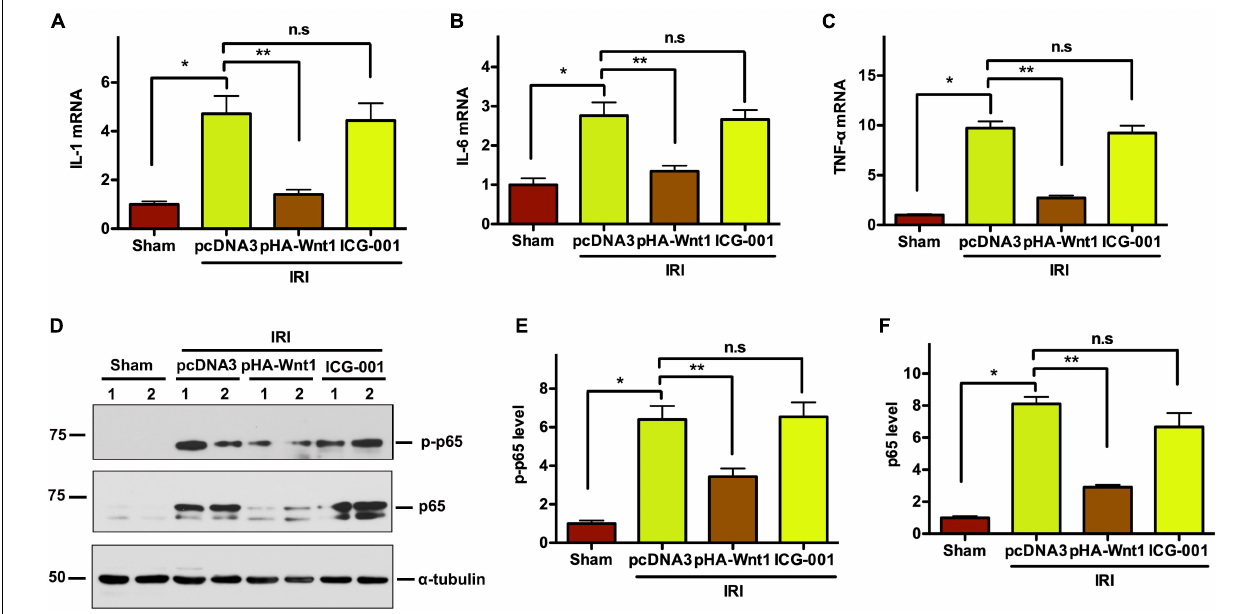
FIGURE 7 | In vivo expression of exogenous Wnt1 before IR attenuates renal inflammation in mice after AKI-CKD progression. (A–C) mRNA expression of IL-1, IL-6, and TNF- α in kidneys of mice. (D–F) Representative Western blot analyses of p65 and p-p65 protein levels. * P < 0.05; ** P < 0.01. n = 5–6.